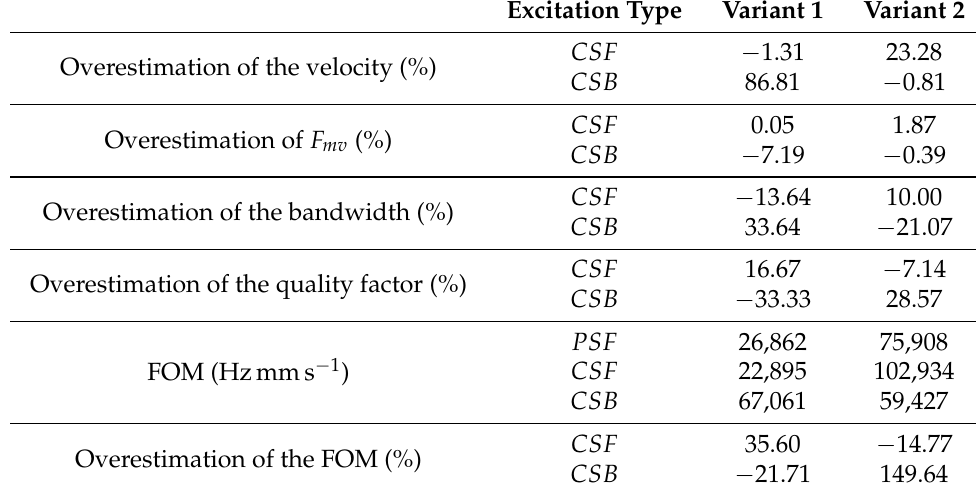
Table 5. Summary of the performances of Variants 1 and 2 under different excitation when the amplitude of the excitation signal is of